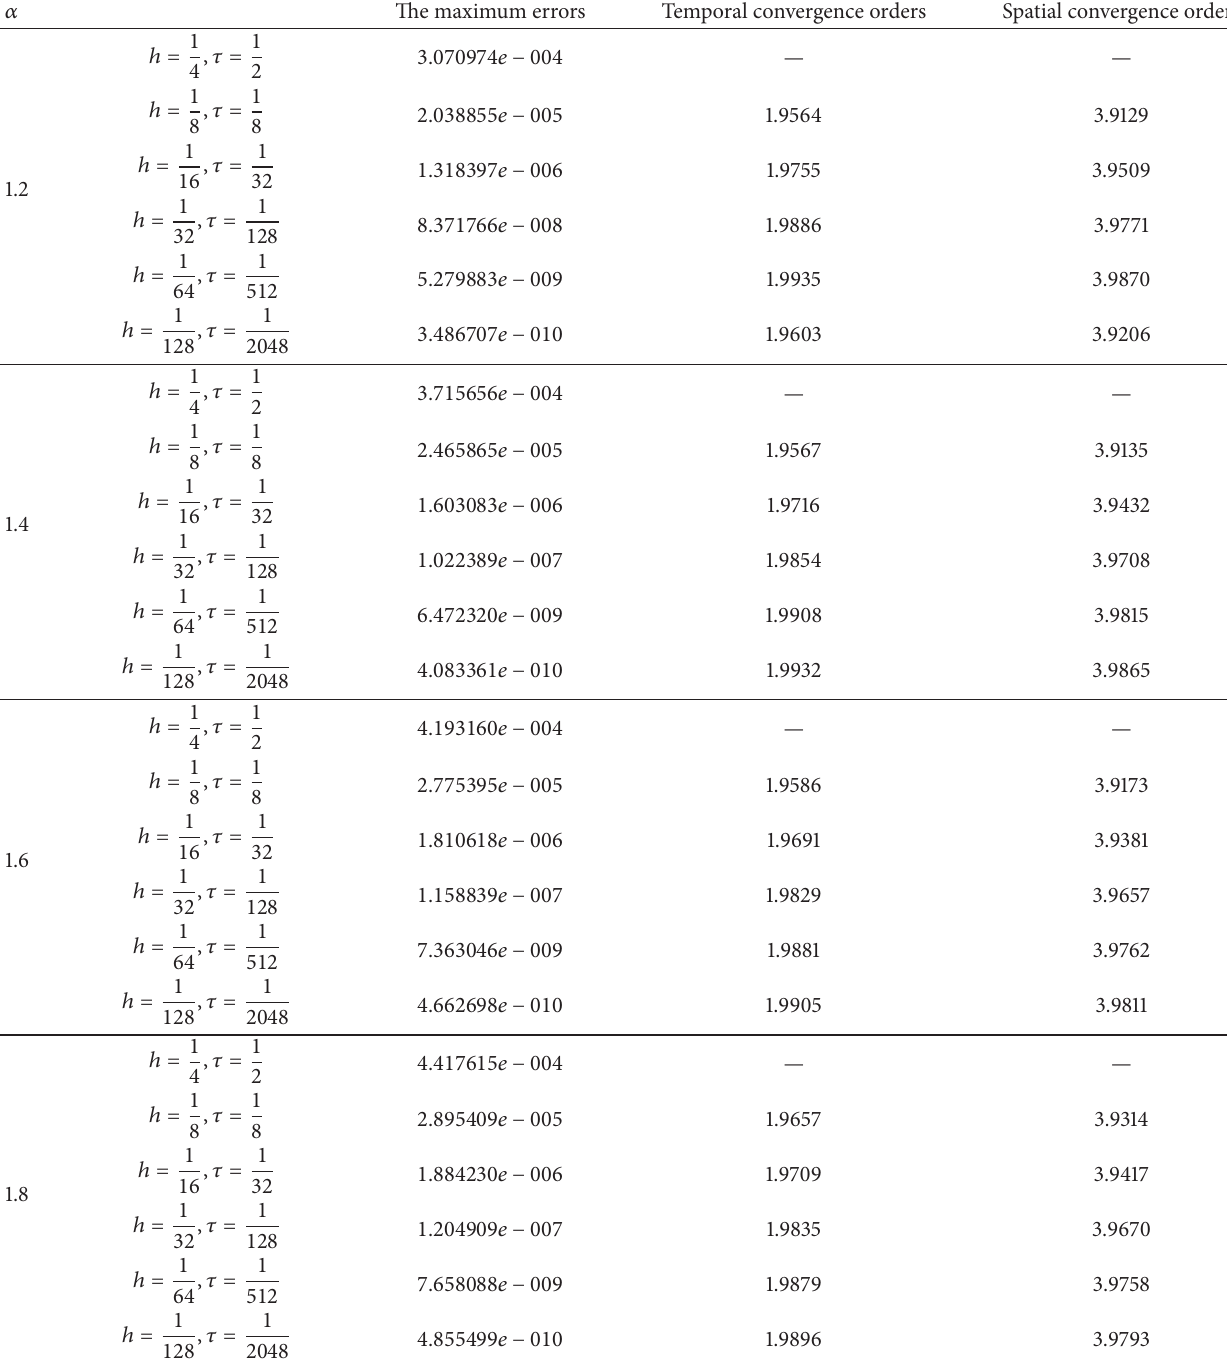
Table 3: The maximum errors and temporal and spatial convergence orders of Example 3 by difference scheme (66).